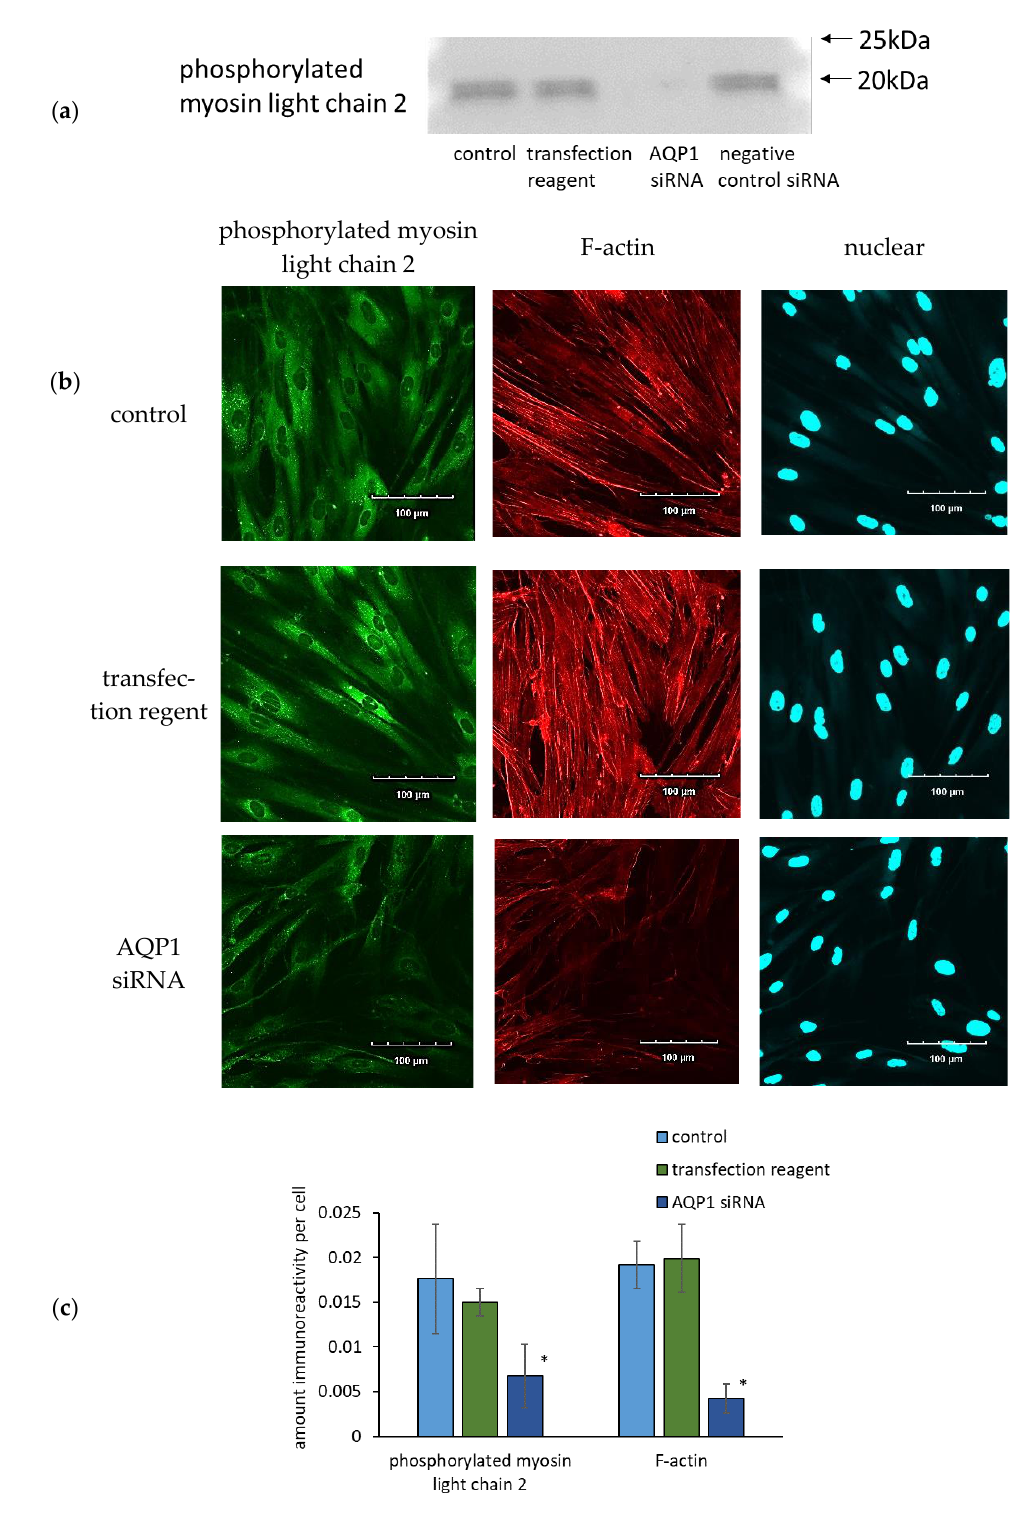
Figure 4. ( a ) Western blotting for phosphorylated myosin light chain 2 in cultured human dermal fibroblasts following AQP1 depletion by AQP1 siRNA. ( b ) Antibody staining for phosphorylated myosin light chain 2 and F-actin in cultured human dermal fibroblasts following AQP1 depletion by AQP1 siRNA. ( c ) Image analysis of the amount of immunoreactivity per cell using ImageJ. *: p < 0.05 vs. the transfection reagent. The figure shows the means ± standard deviations ( n = 3).